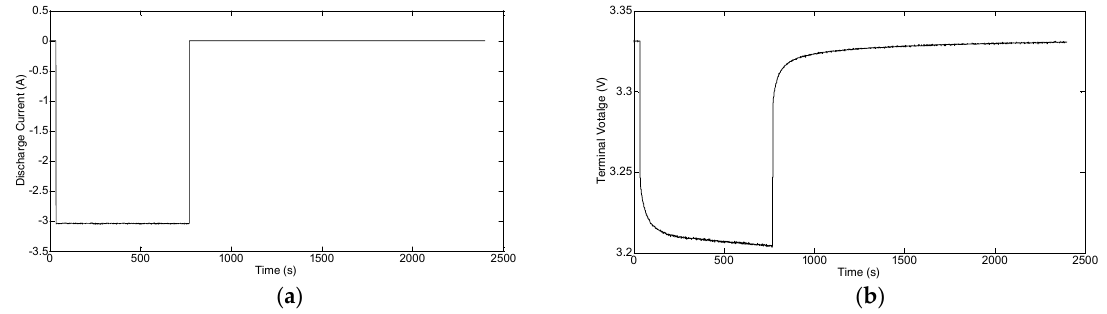
Figure 2. The single pulse discharge curve ( a ) the single pulse discharge current curve; ( b ) the single pulse discharge voltage curve.